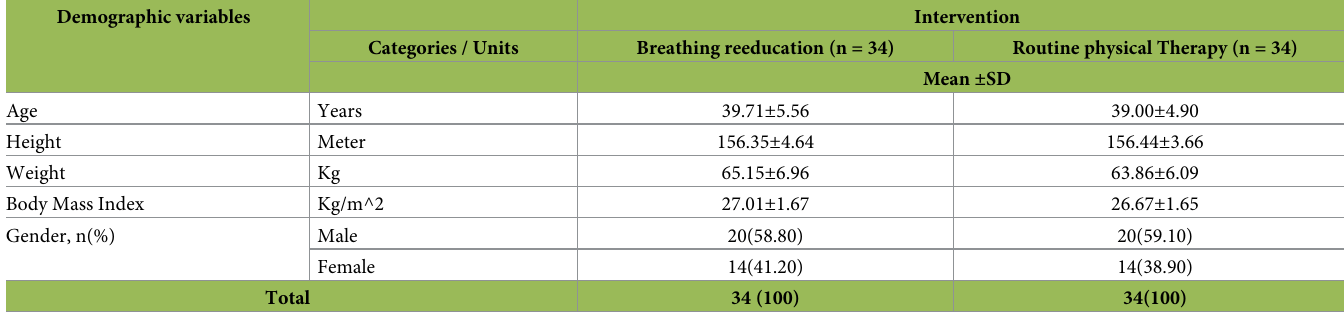
Table 1. Baseline descriptive chracteristics (n = 68).